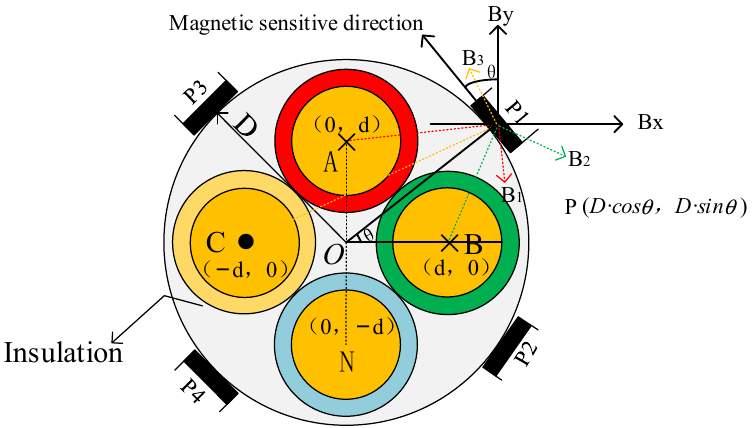
Figure 1. Three-phase four-wire cable current measurement model.